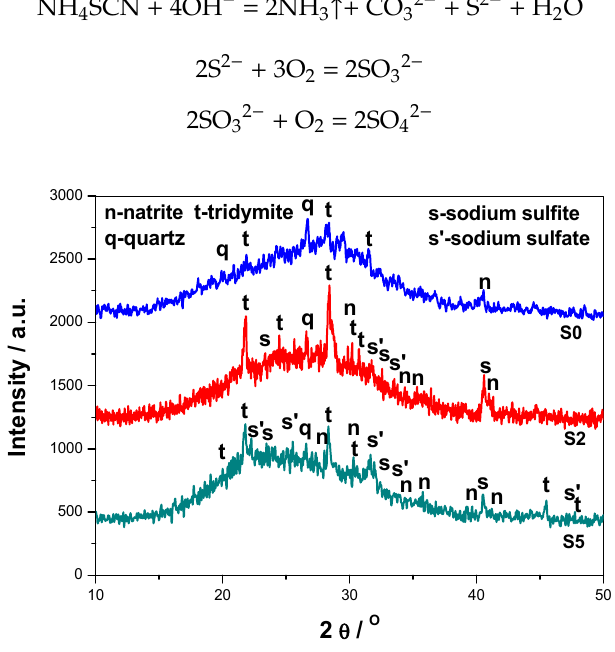
Figure 7. XRD of samples after combustion.